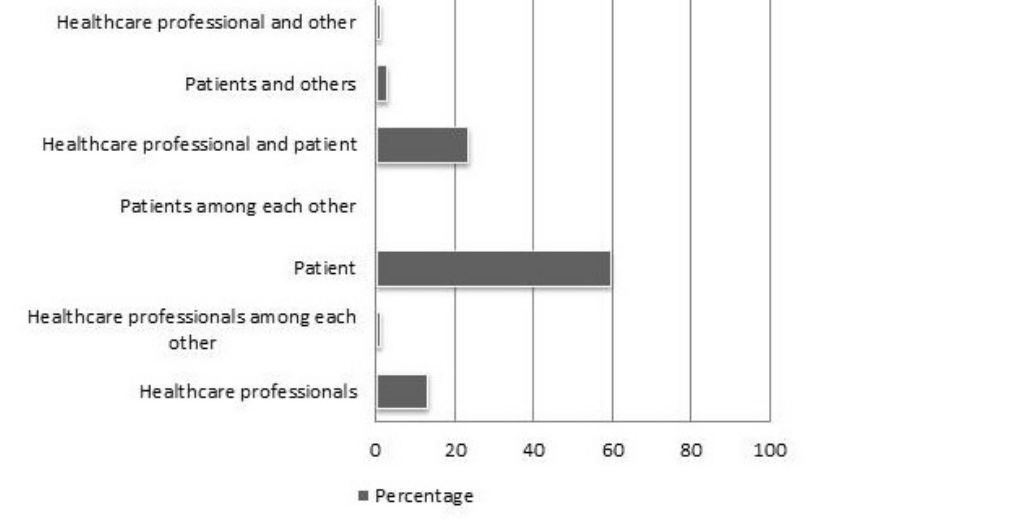
Figure 2. Intended users of the tools. Data is presented as percentage of total number of tools (n=116). Tools can have multiple intended users.